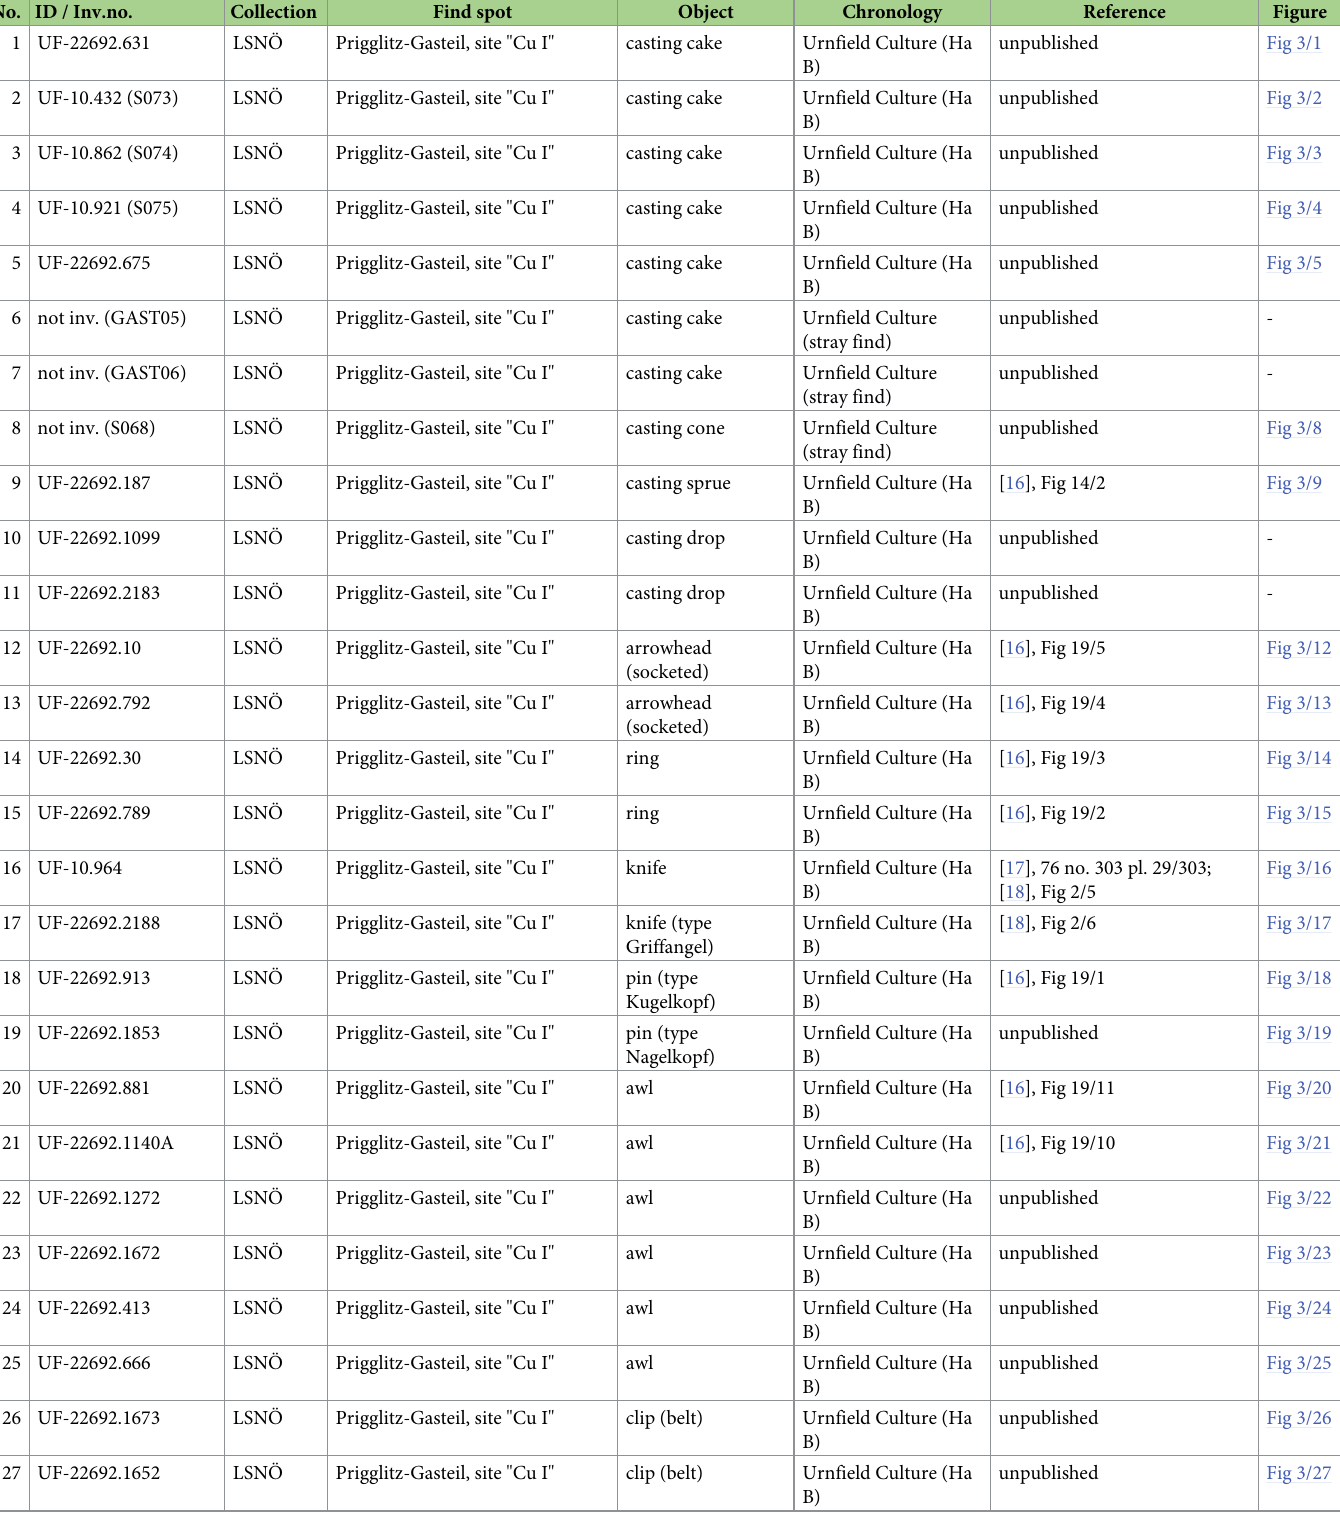
Table 1. Objects analysed in this paper. No. ID /